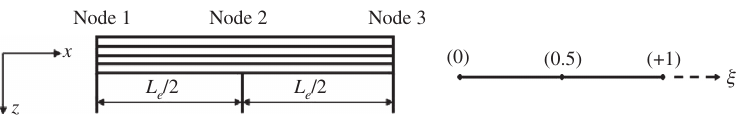
Figure 3 A three-noded beam element and its intrinsic coordinates.